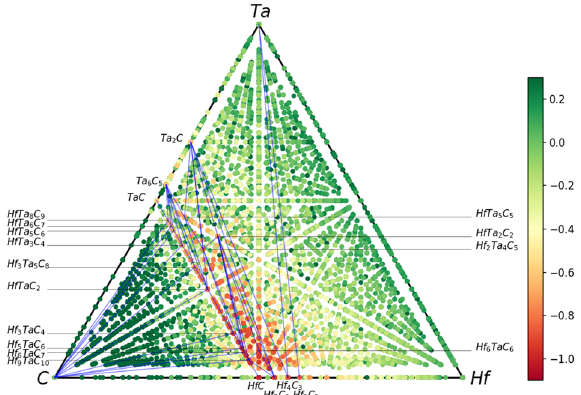
Fig. 6 Phase diagram of the Hf – Ta – C system. Energies of formation (in eV atom − 1 , with the scale given by the color bar) of all the sampled structures of the Hf – Ta – C system are given at ambient